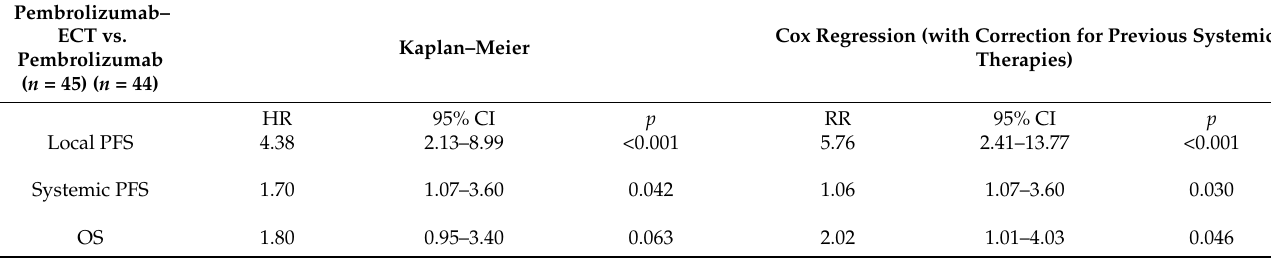
Table 5. Kaplan–Meier hazard risk evaluation and Cox regression analysis with risk ratio evaluation corrected for previous systemic